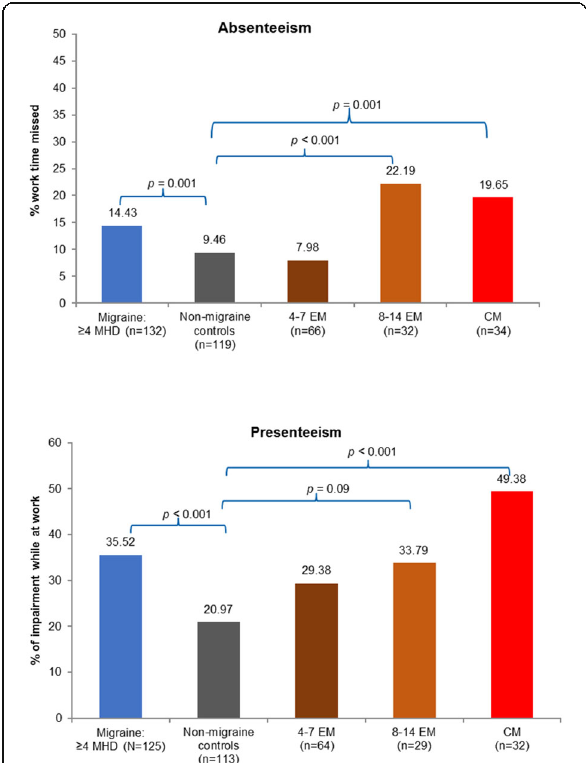
Fig. 4 Work productivity loss in migraine subgroups vs propensity score matched non-migraine controls by the WPAI metricsMann- Whitney tests were used for analysis.CM, chronic migraine; EM, episodic migraine; MHD, monthly headache day; WPAI, work productivity and activity impairment.